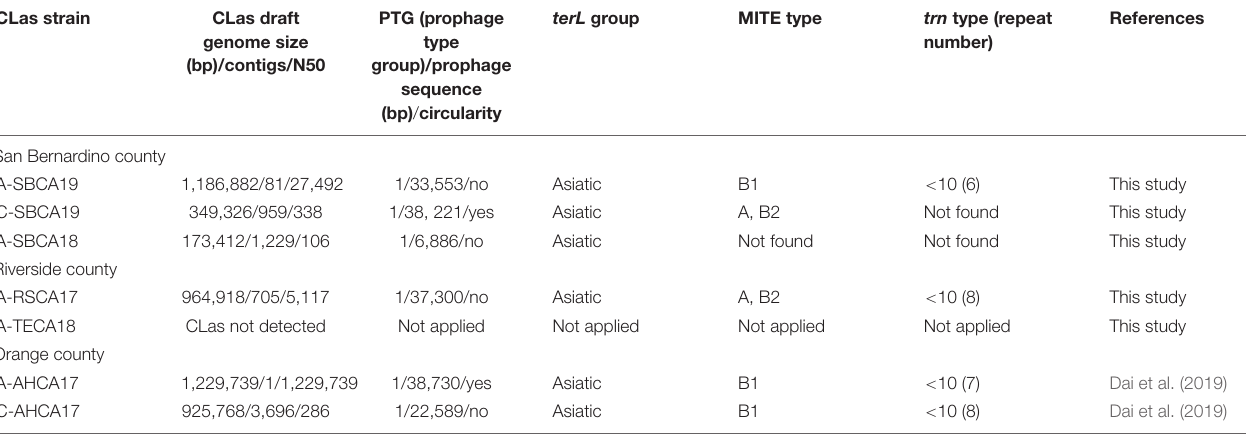
TABLE 3 | Genomic characterization and comparisons of “ Candidatus Liberibacter asiaticus” (CLas) strains from ACP or citrus samples collected from three counties in southern California.